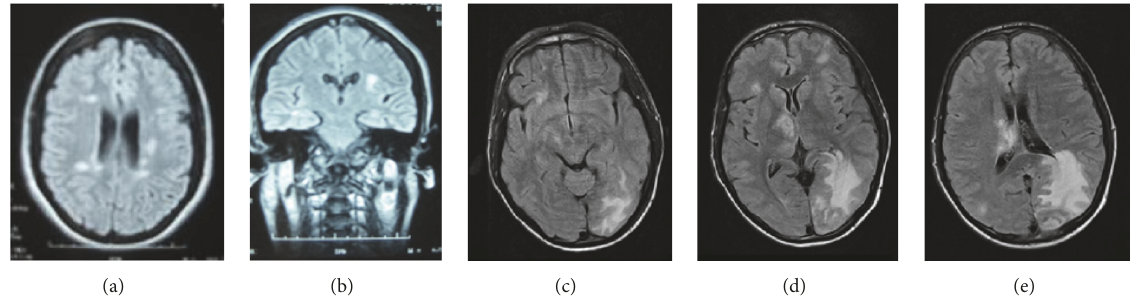
Figure 2: Brain MRI showed demyelinating lesions in a patient with multiple sclerosis (a, b) [S1] and haemorrhagic leukoencephalopathy due to toxoplasmosis in HIV patient (c, d, e)